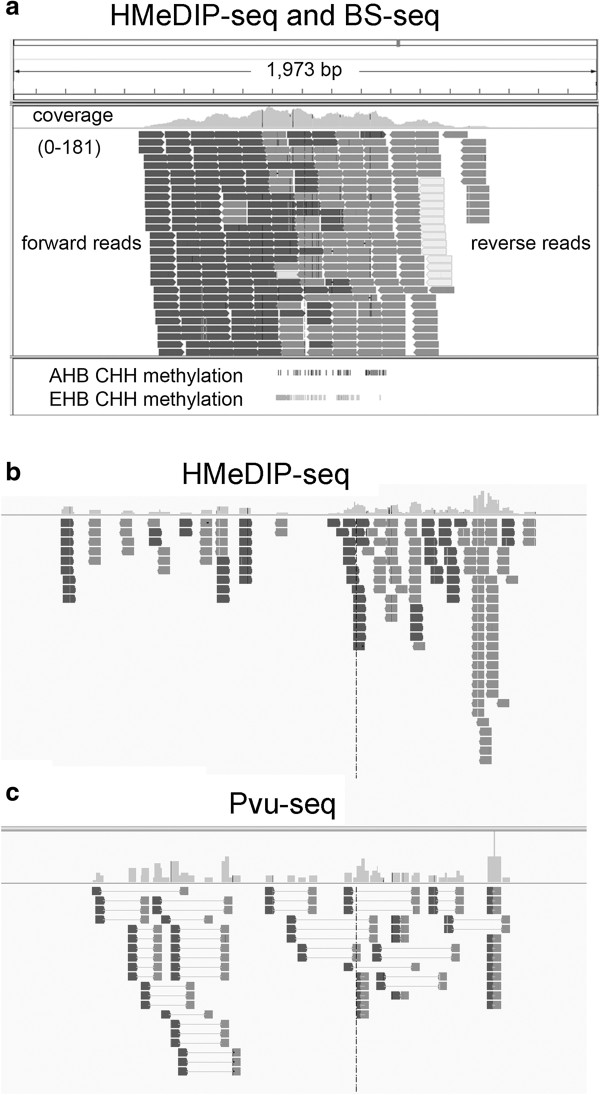
Validation of CHH modifications based on MeDIP-Seq. a, A large MeDIP peak in Africanized honey bees (AHB) that has a large amount of CHH modifications but no CG methylation in both European (EHB) and AHB. Coverage (0-181) represents the sequence coverage of mDIP-Seq fragments (the gray line is 0 and the top of the peak is 181). Forward reads are shown in black and reverse reads are shown in gray. The white boxes show reverse reads that did not have forward reads that could be aligned uniquely to the genome. The bottom portion shows the CHH modifications in AHB and EHB. b, HMeDIP-Seq analysis of a region of the genome that has a large peak of immunoprecipitated DNA. The histogram on the top shows the relative number of RNA-Seq fragments that align to the indicated region of the genome. Forward sequences are shown in red and reverse sequences in blue. c, Pvu-Seq analysis of the same region of the genome. Notice the good concordance between the two analyses.